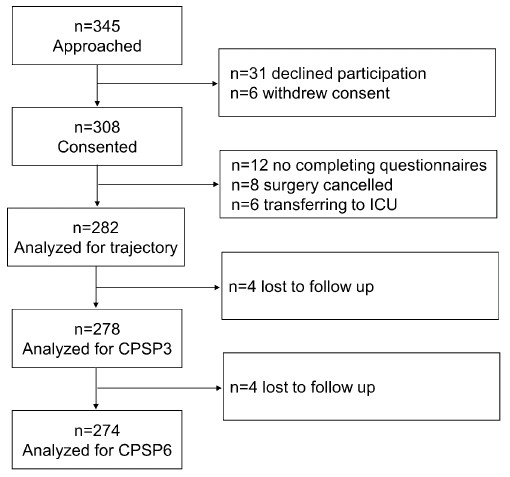
Figure 1. Flow diagram. ICU intensive care unit, CPSP Chronic postsurgical